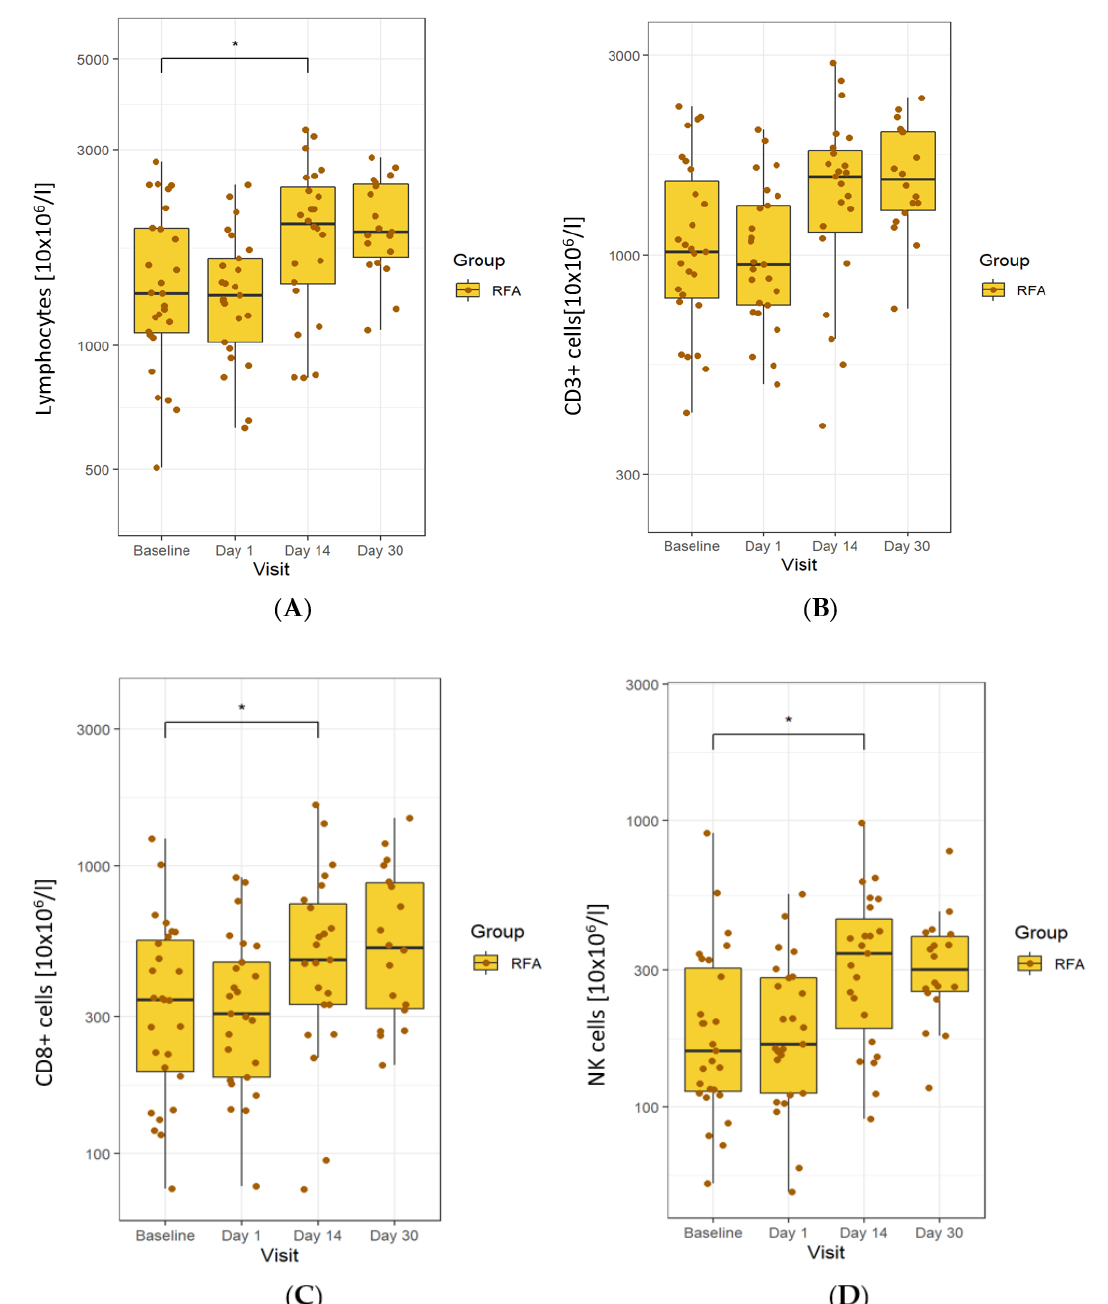
Figure 4. Changes in cells observed in the RFA-treated group. ( A ) An increase in the total lymphocytes on day 14 until day 30. ( B ) A rise in total T cells. ( C ) An increase in the number of CD8+ cells on day 14 until day 30. ( D ) An increase in NK cells on day 14, remaining until the end of study. The line in the middle of the box represents the median; the upper and lower ends of the box represent the first and third quartiles, respectively, excluding outliers. The upper and lower whiskers show the maximum and minimum scores, respectively. Individual dots represent individual patients’ values. Asterisks show the statistical significance. The y -axis is in logarithmic scale.